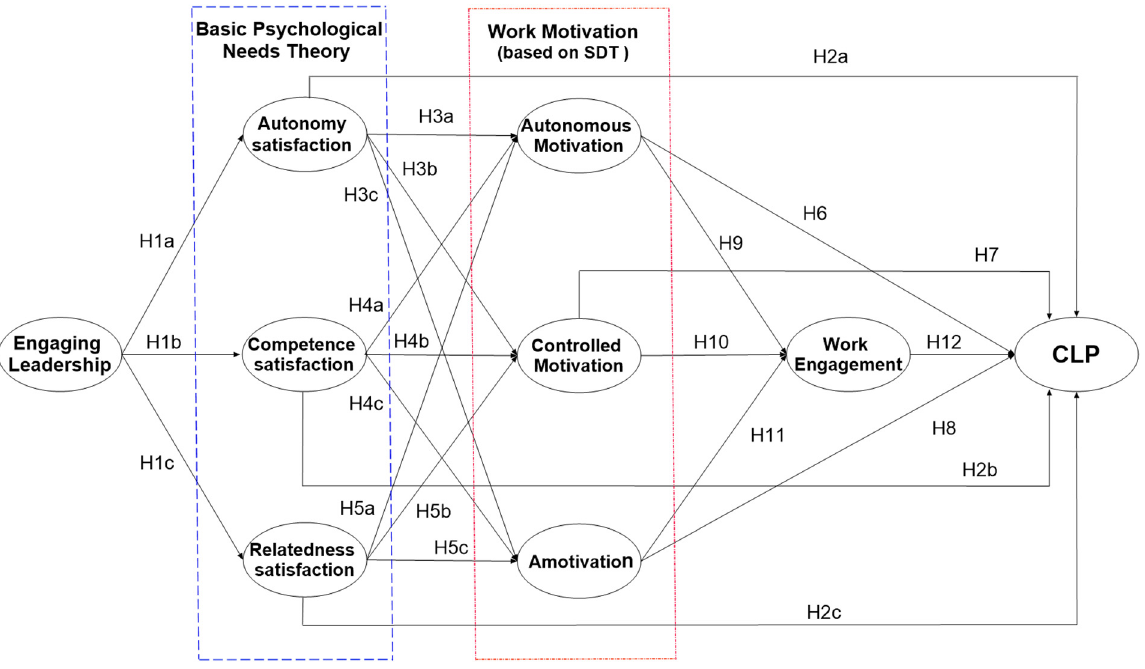
Figure 1. Structural model.